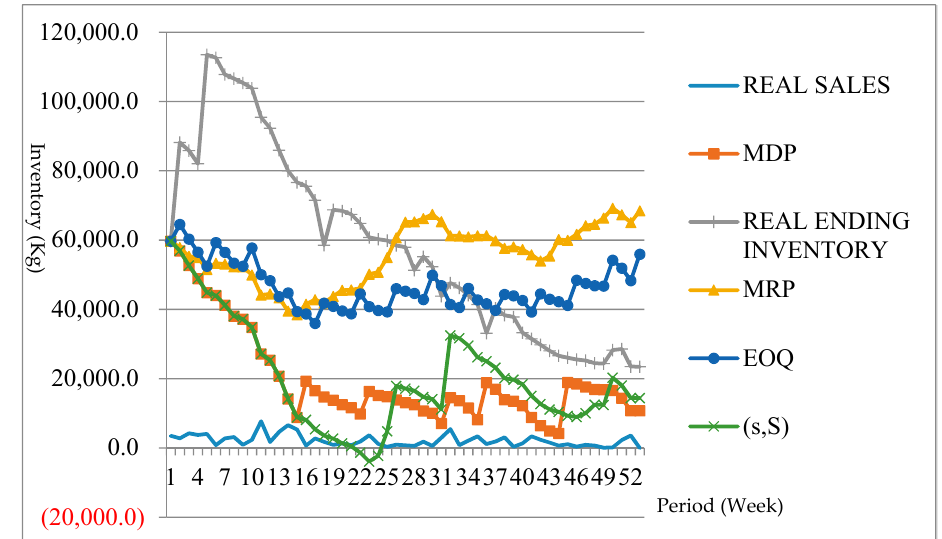
Table 6. Optimal policy.